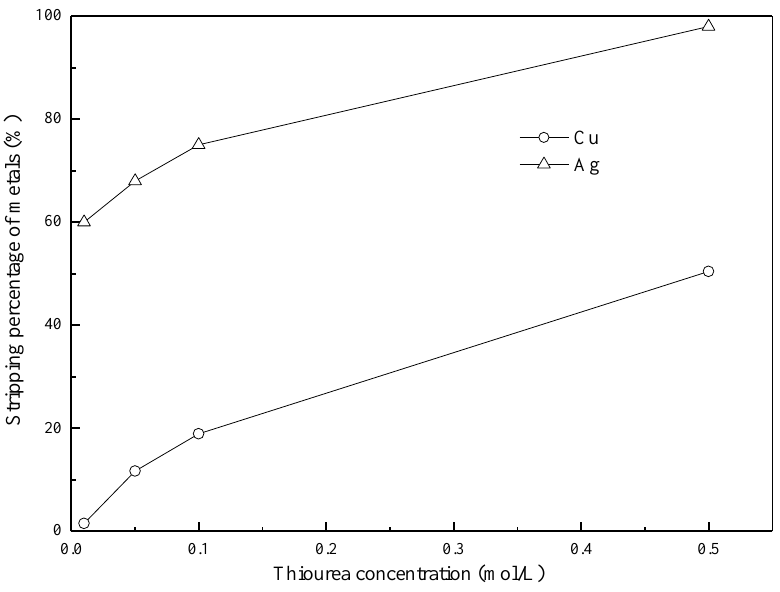
Figure 6. Stripping percentages of Cu(II) and Ag(I) at various thiourea